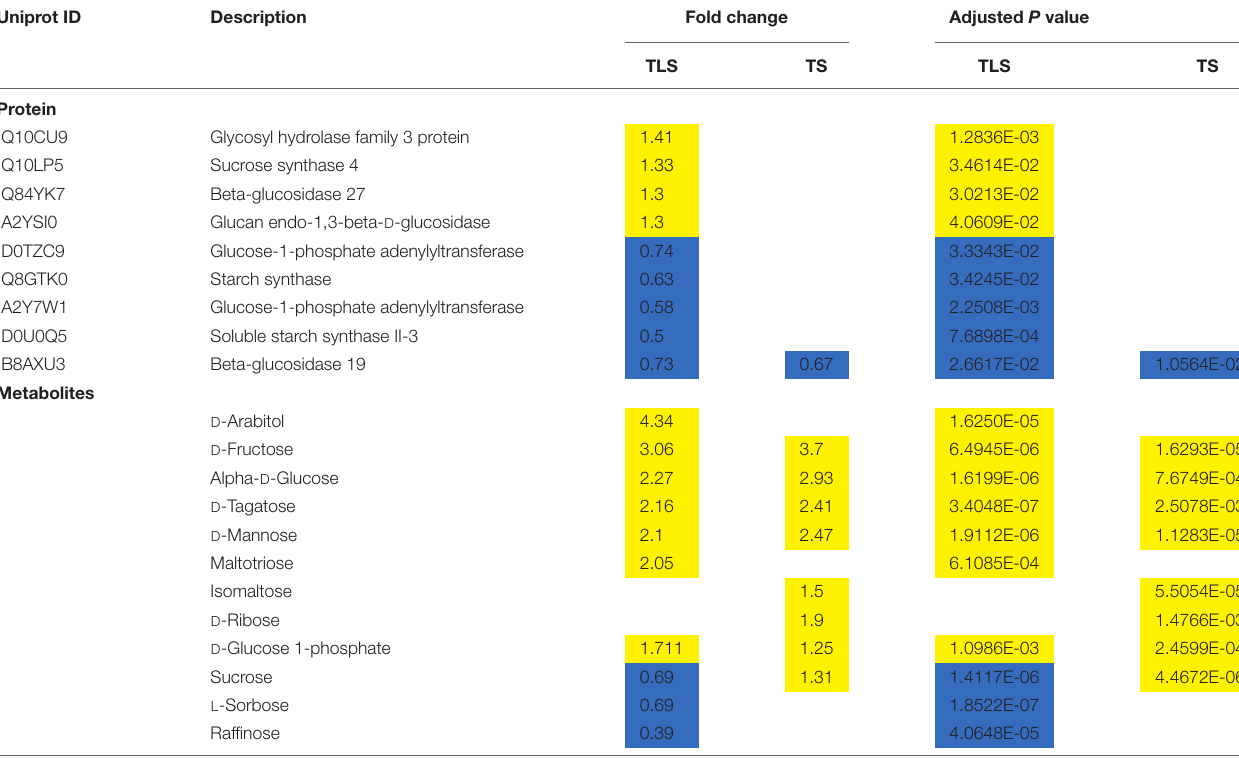
TABLE 5 | Differentially expressed proteins and metabolites related to saccharide metabolism. Uniprot